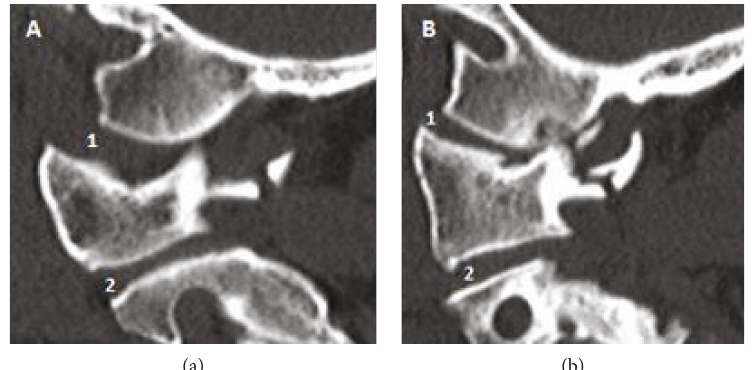
Figure 3: Cervical spine CT scan. (a) Widening and slight anterior subluxation of the right atlantooccipital joint (1) with preserved anatomy of C1 – C2 lateral mass joint (2). (b) Slight anterior subluxation of the left atlantooccipital joint (1) and widening of C1 – C2 lateral mass joint (2).